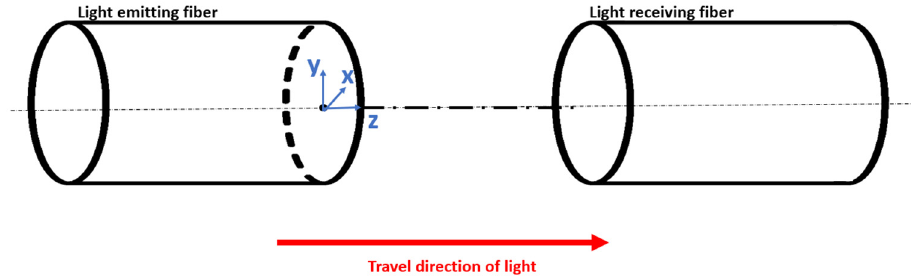
Figure 2. Schematic overview of the air gap (including coordinate system and direction of tip mo- tion).